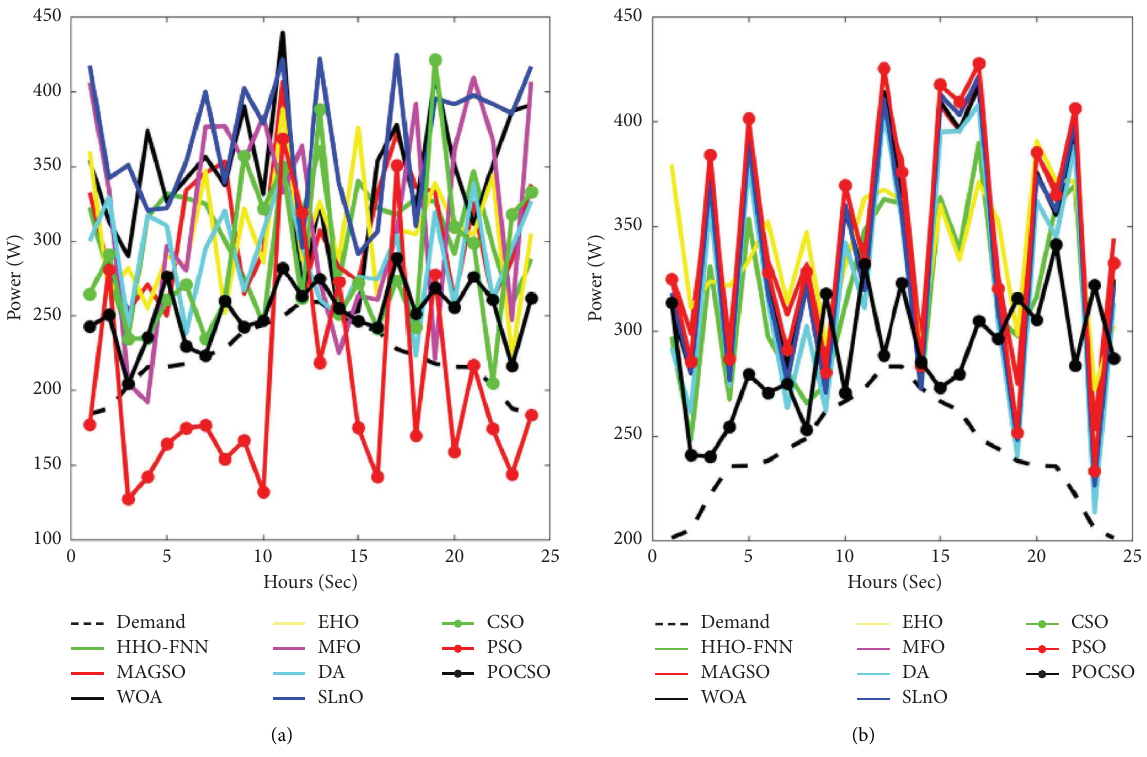
Figure 12: Demand response of several optimization techniques for (a) IEEE-14 and (b) IEEE-30 bus systems.